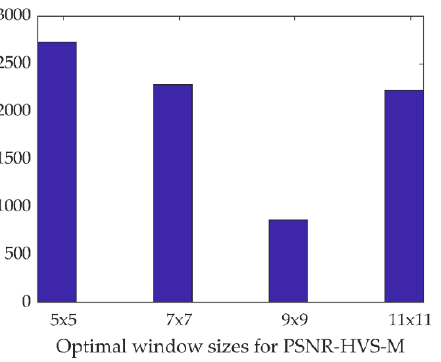
Figure 6. Numbers of test images with different optimal window sizes according to PSNR-HVS-M.